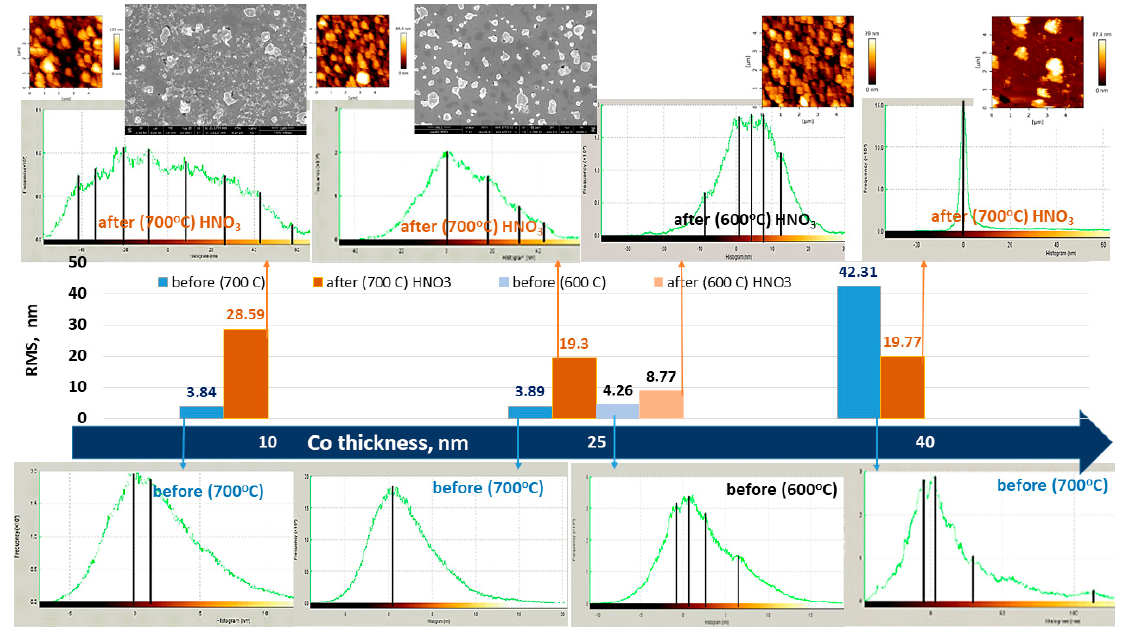
Figure 11. The dependence of the graphene surface morphology on sacrificial Co layer thickness and annealing temperature. The surface morphology was measured before and after the removal of the sacrificial catalytic interlayer. The two-step growth process was used. The annealing temperature was 700 °C, ion beam energy—800 eV, hydrocarbon ion beam treatment time—15 min.